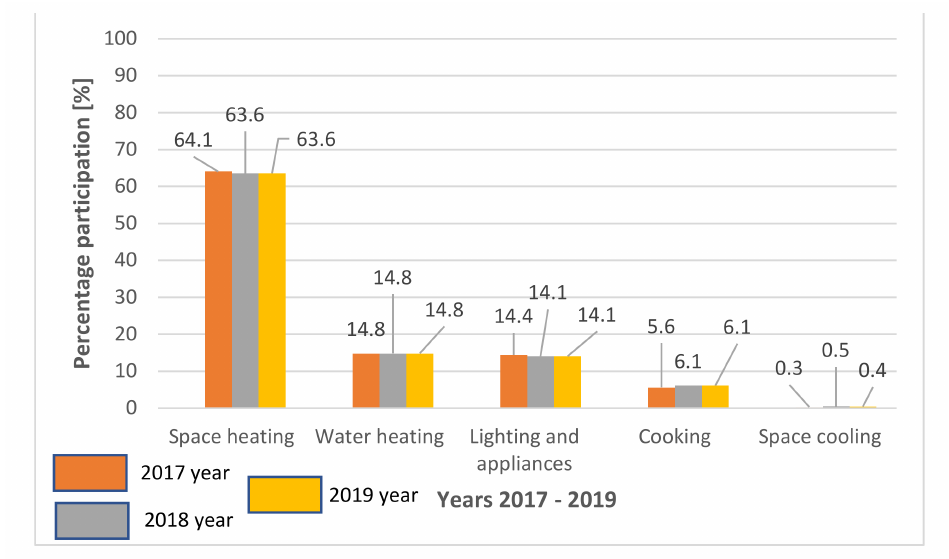
Figure 1. Energy consumption in EU households in 2017–2019 years. Source: own study, based on